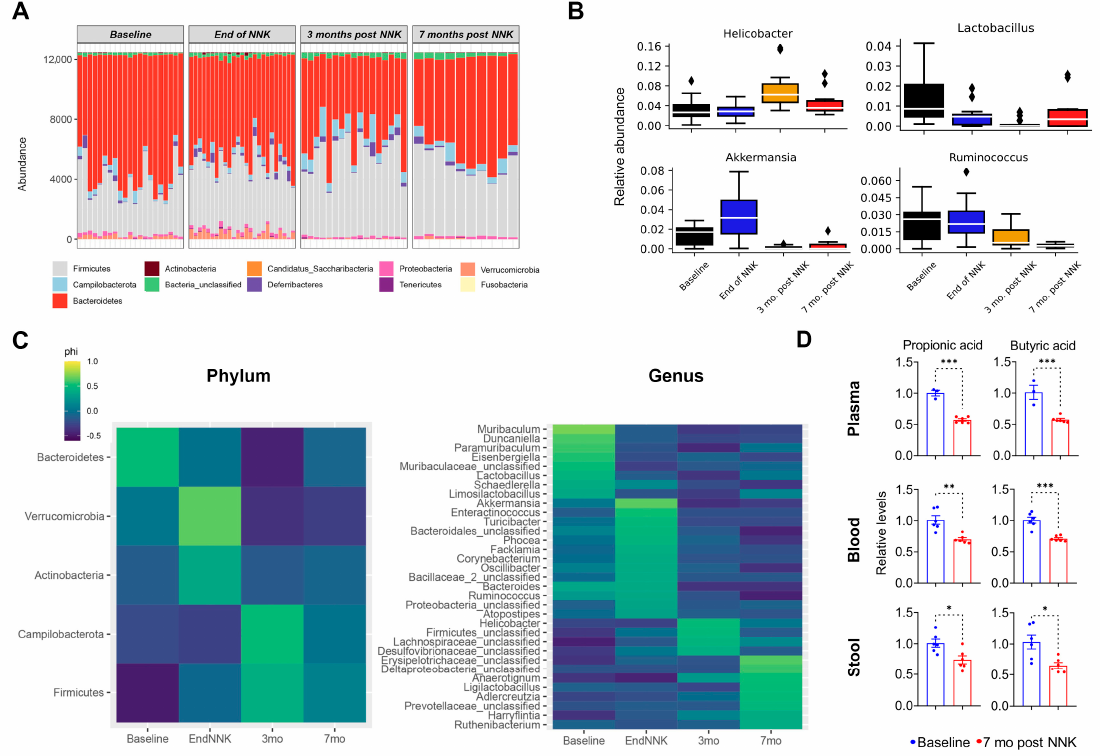
Figure 3. Specific phyla and genera drive shifts in the gut microbial ecosystem during LUAD patho- genesis in Gprc5a − / − animals. ( A ) Changes in abundance of bacterial phyla at different